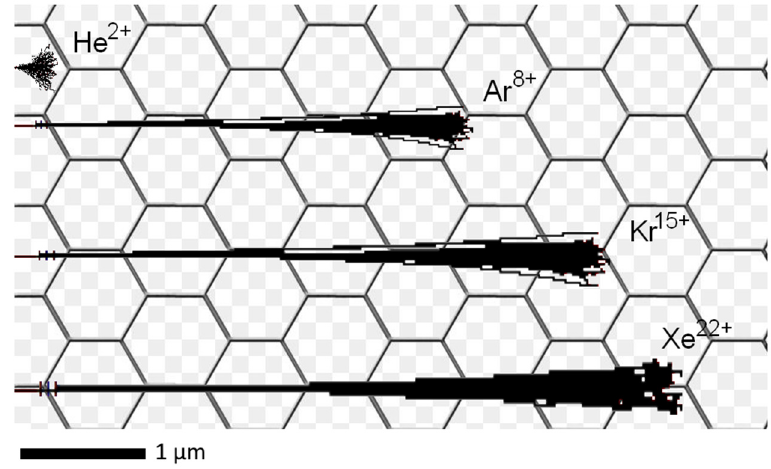
Figure 1. Schematic representation of ion-damage trajectories in ceramics.